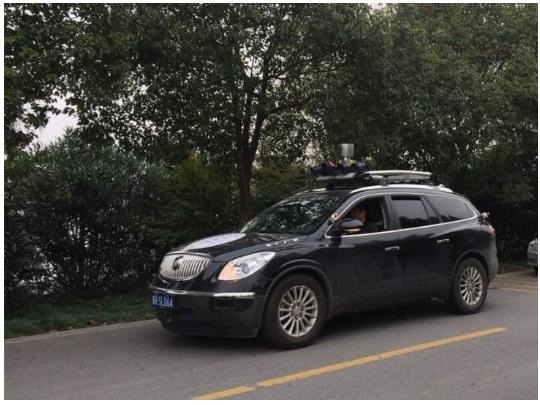
Figure 3. Driverless car developed by Tsinghua University.